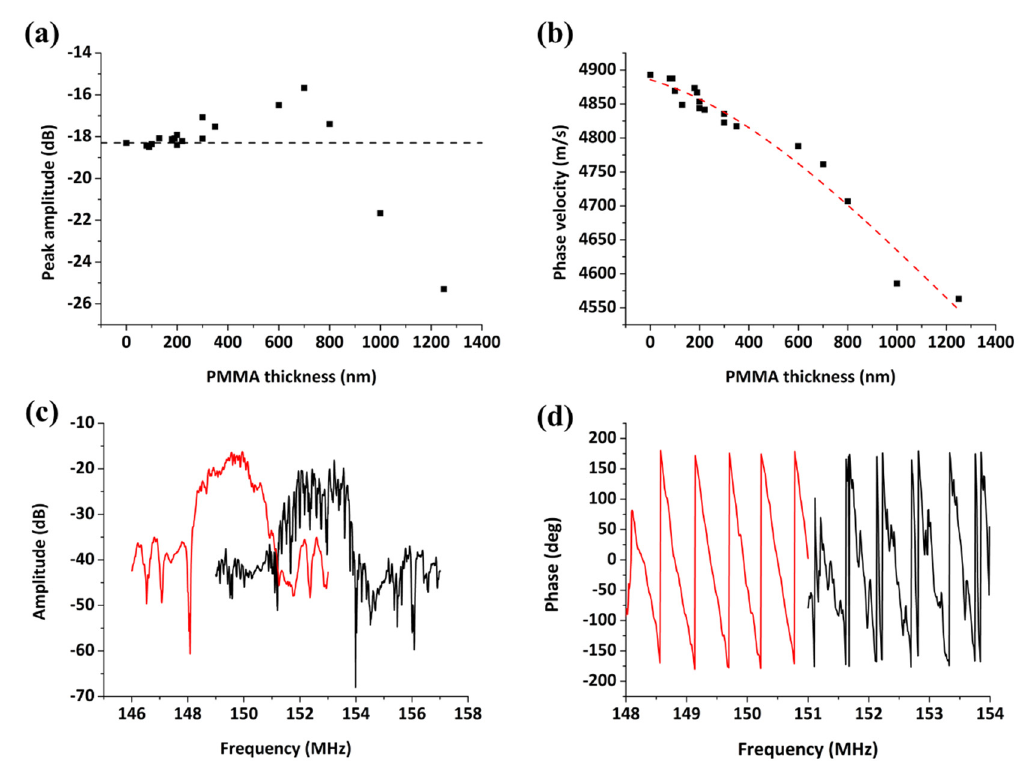
Figure 5. Peak amplitude ( a ) and phase velocity ( b ) shift as a function of the PMMA guiding layer thickness, uncoated versus PMMA-coated device (700 nm) in air: ( c ) amplitude and ( d ) phase spectrum .